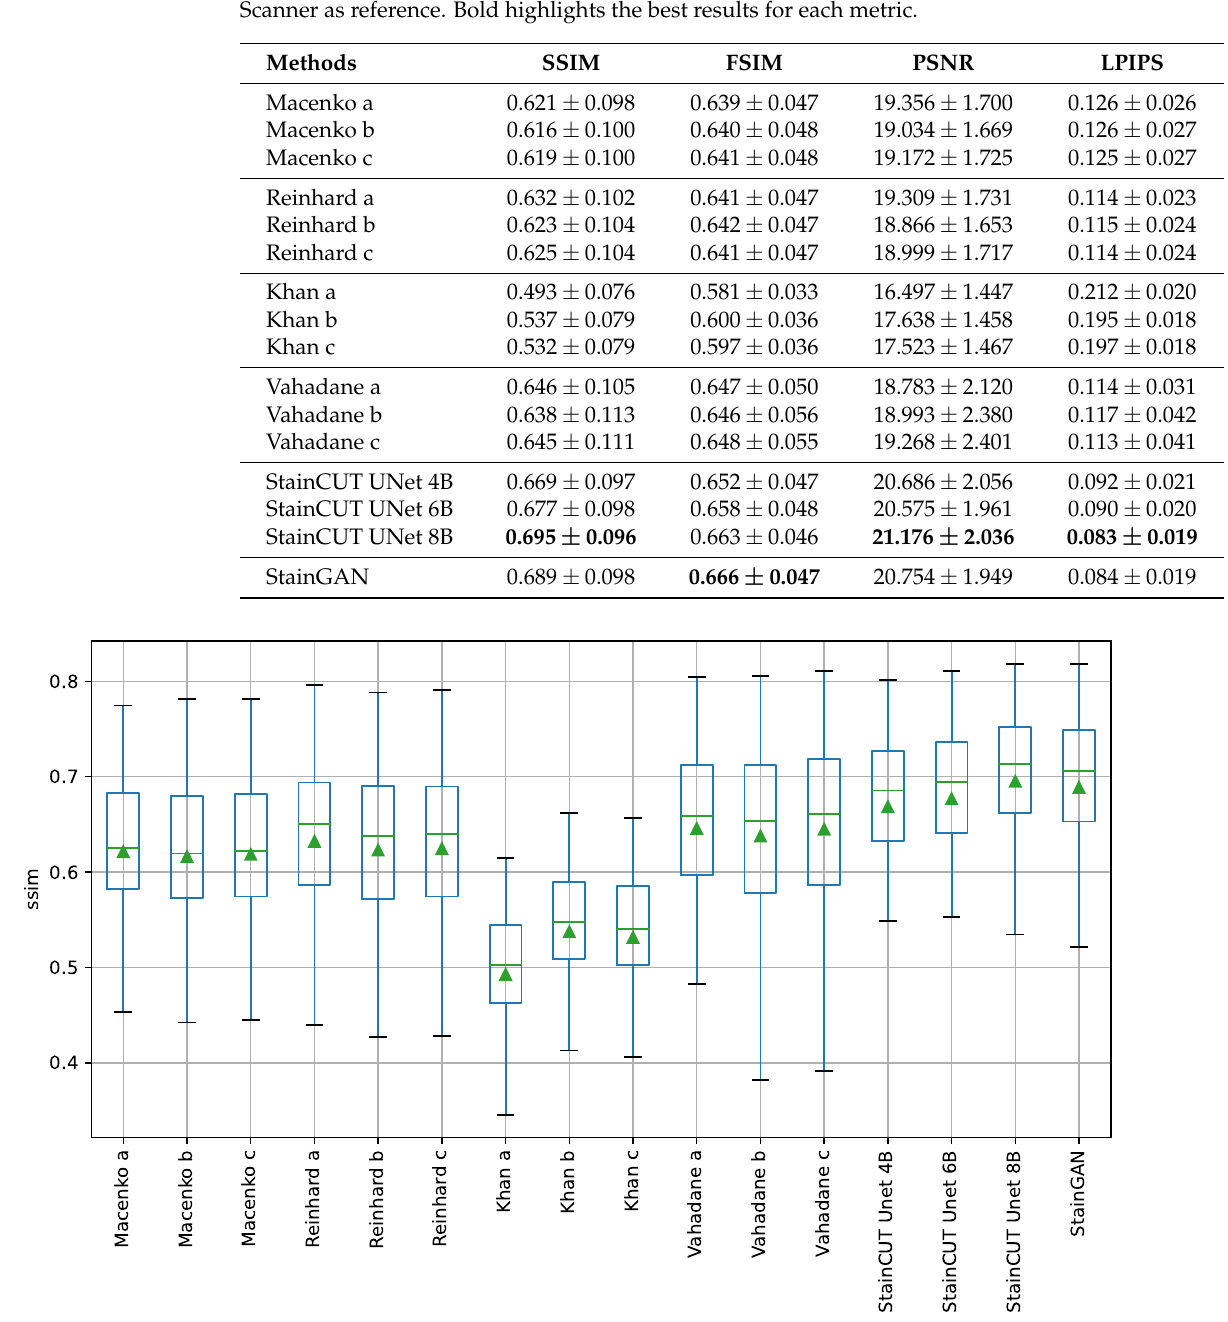
Figure 5. Boxplots from the evaluation of the SSIM metric for all compared methods on the MITOS- ATYPIA dataset. Each box is drawn from the first to the third quartile. The horizontal line represents the median value, and the triangle represents the mean. The whiskers indicate the minimum and maximum value of the